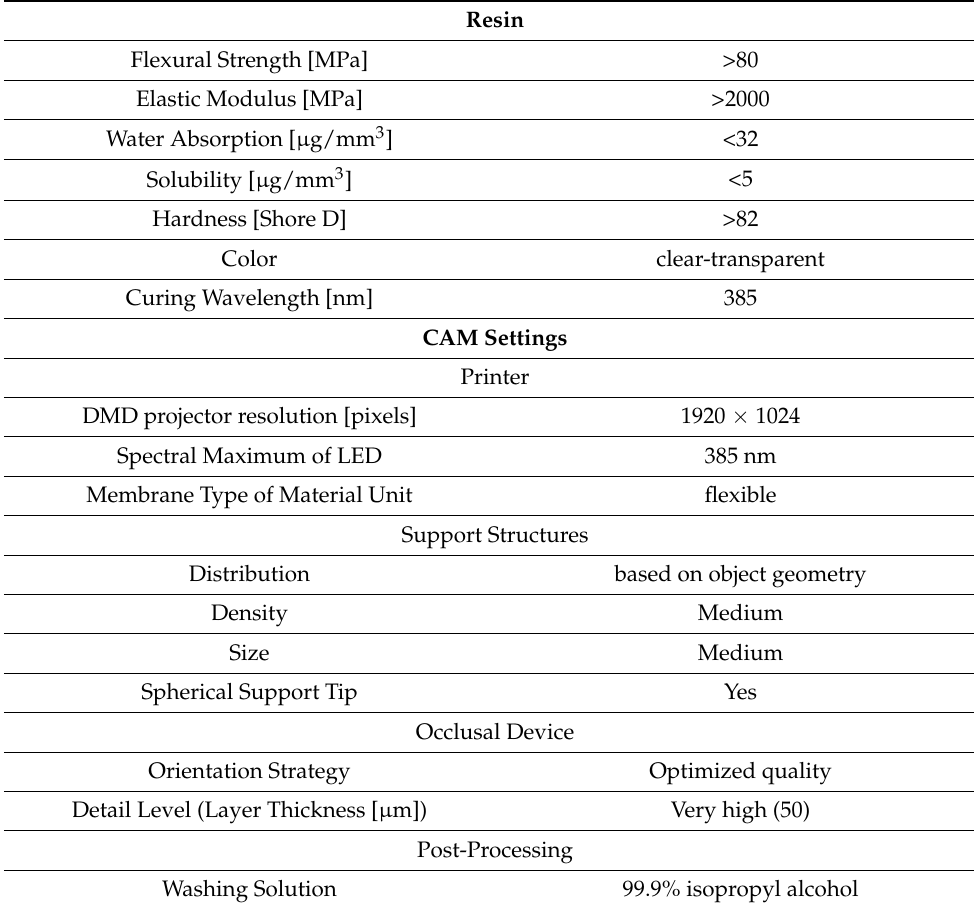
Table 1. 3D Printing